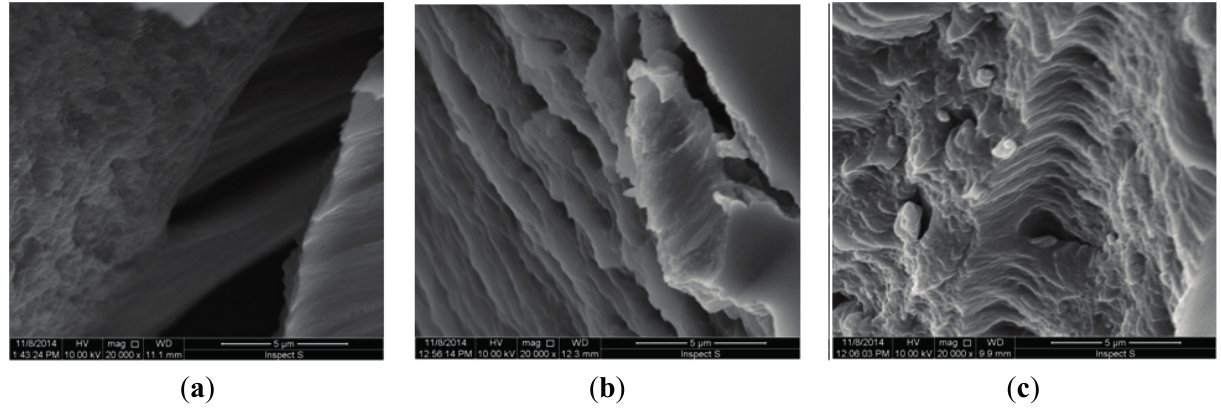
Figure 2. The SEM images of hydrogels: ( a ) without PAMAM-NH 2 (E1); ( b ) with PAMAM-NH 2 G2 3 mg/g (EP3); ( c ) with PAMAM-NH 2 G3 3 mg/g (EP7) (magnification